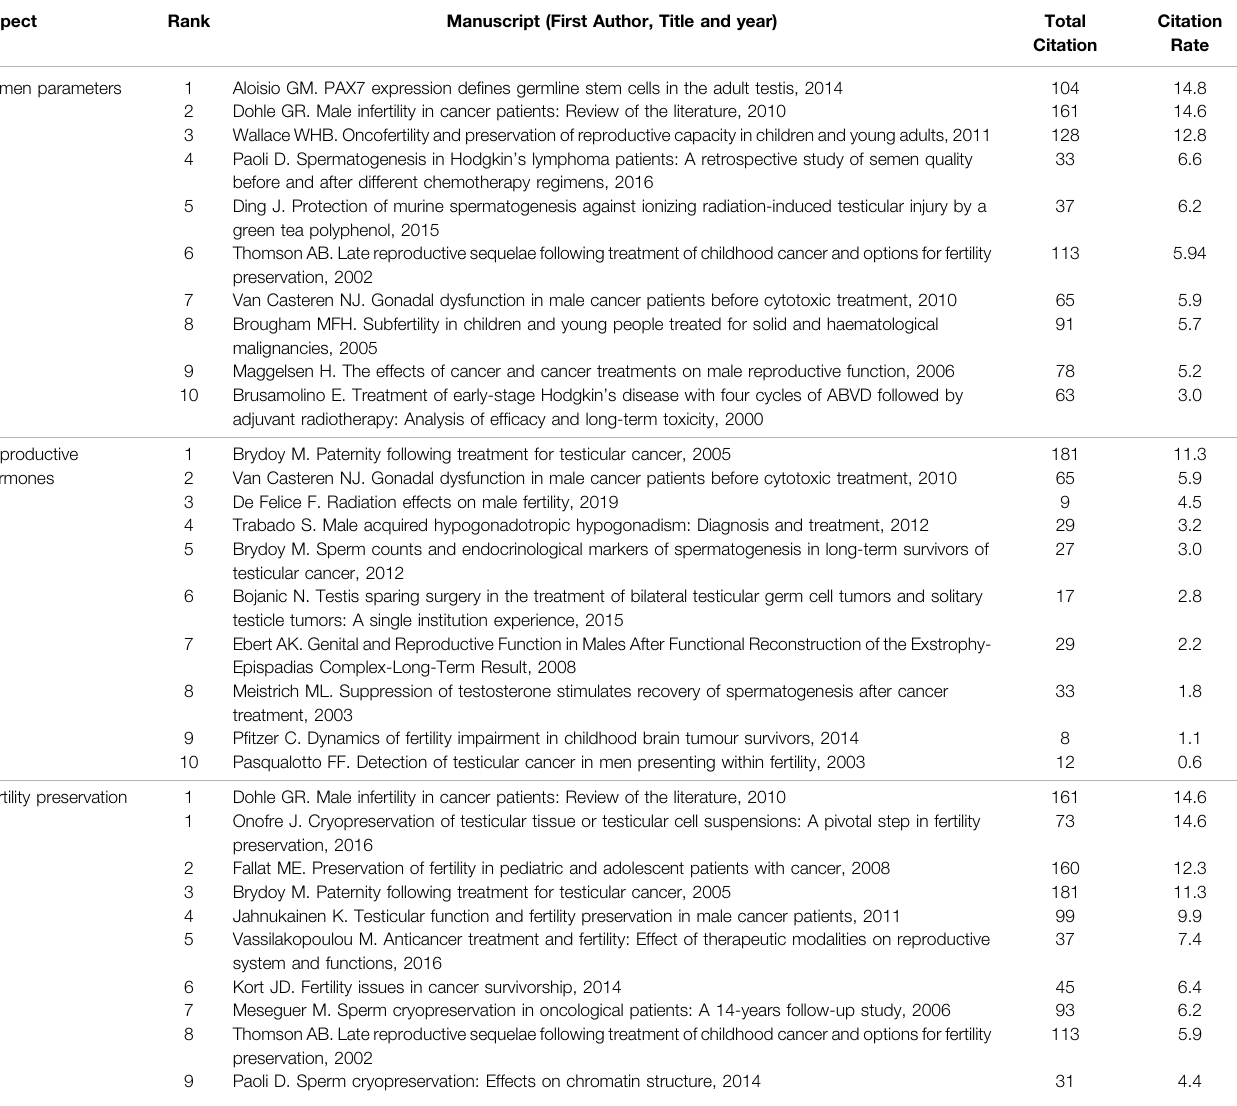
TABLE 3| Top10articles investigating radiotherapy andmalefertility each from theaspect ofsemenparameters,reproductive hormonesand fertilitypreservationbasedon the citation rate. Aspect Rank Manuscript (First Author, Title and year)